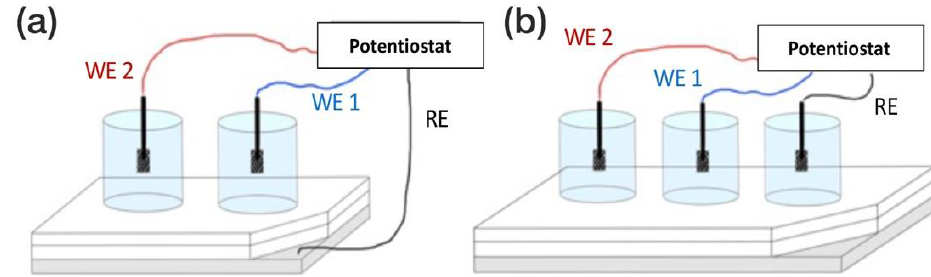
Figure 11. ( a ) The reverse configuration and ( b ) the schematics of the three-electrode, no substrate connection. (Personal drawing; inspiration from [92]).